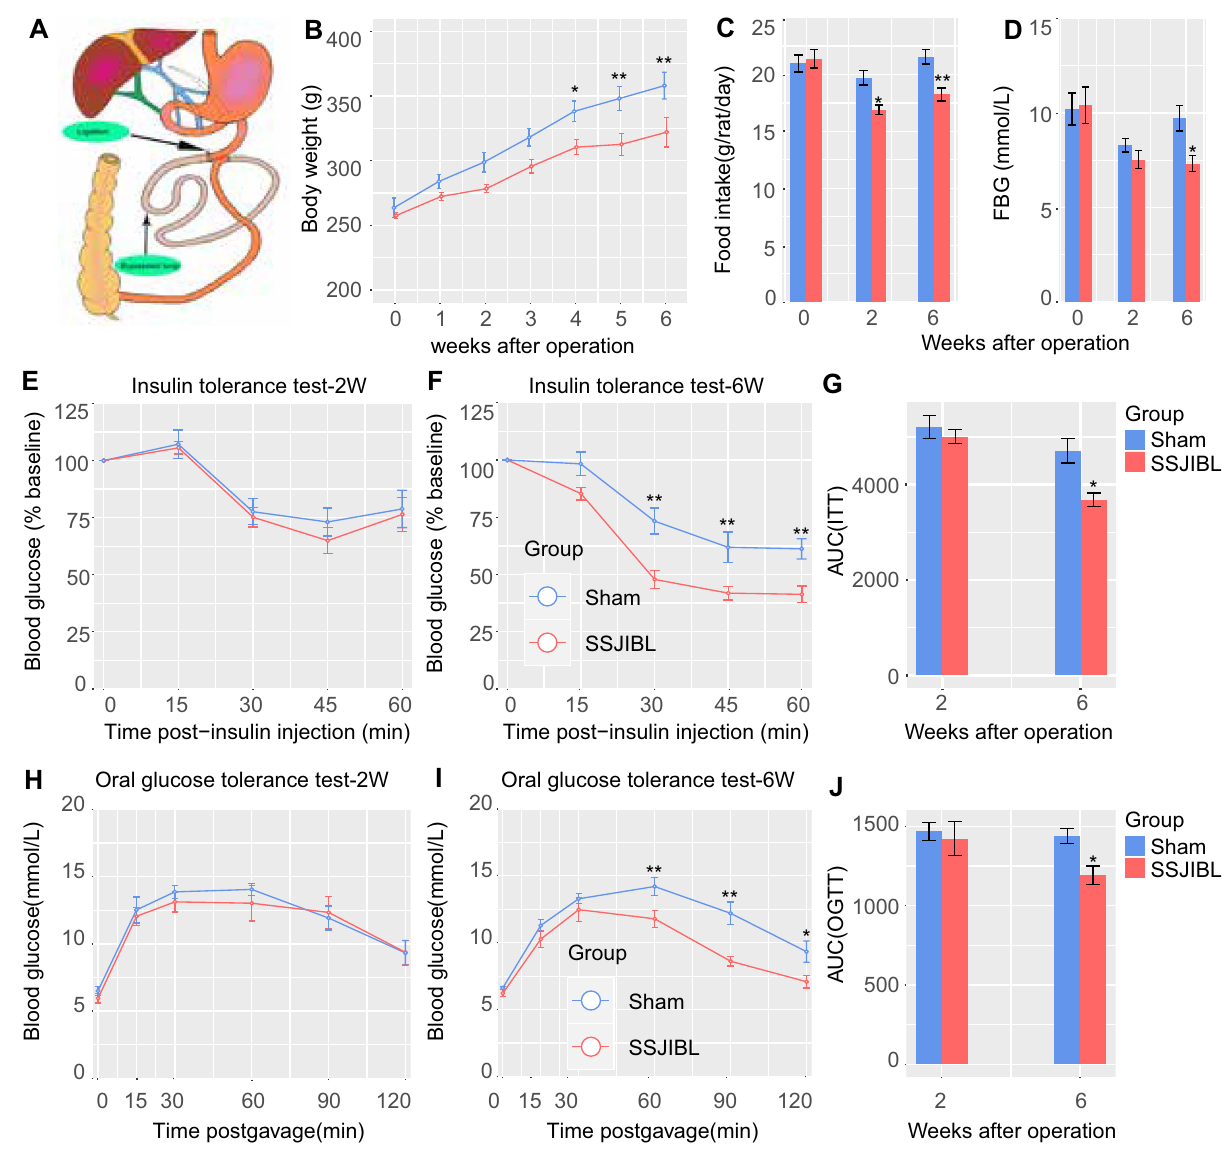
Figure 1. SSJIBL reduced weight gain, food intake, and fasting blood glucose level, and improved glucose tolerance and insulin sensitivity in GK rats in a time-dependent manner. Rats were randomly divided into 2 groups (n = 8 for SSJIBL, n = 7 for Sham). ( A ) For the SSJIBL surgery, a point 40 cm proximal to the ileocecal valve was used as the reference point. Starting proximally from this point to 6 cm distal to the Treitz ligament, approximately 60% of the length of the entire small bowel was bypassed, and bowel continuity was restored by a side-to-side anastomosis between the proximal jejunum and the ileum. The luminal occlusion was performed at the first portion of the bypassed segment by using a ligation of 0 silk suture. ( B ) Body weight of SSJIBL and Sham treated rats. ( C ) Average daily food intake for the above 2 groups of rats 2 W and 6 W postoperation. ( D ) Fasting blood glucose level (FBG). ( E , F ) Effect of SSJIBL on percentage of initial blood glucose level during insulin tolerance test (ITT). ( G ) Area under the curve (AUC). ( H , I ) Effect of SSJIBL on glucose tolerance measured by oral glucose tolerance test (OGTT). ( J ) AUC. Error bars are expressed as means ± SEM. Statistical significance was determined by two-tailed Student’s t test or two-way ANOVA. * P < 0.05, ** P <